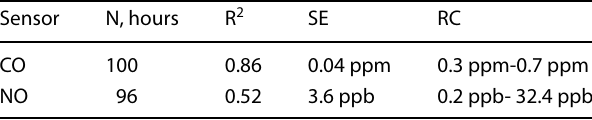
Table 1 Calibration 1 results of B4 gas sensors